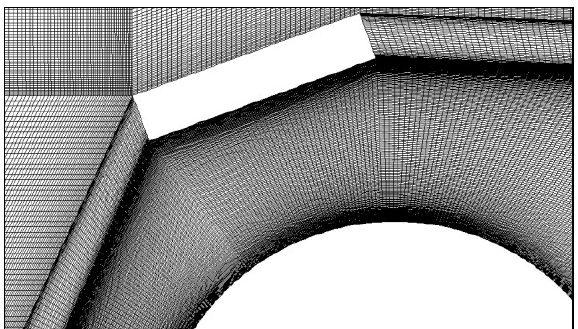
Fig. 3. Image showing near field meshes from the cylinder for A70 case before the mesh adaption process. Flow is from left to right. Computational domain was divided into various blocks with respect to the case, but each block was meshed with structured